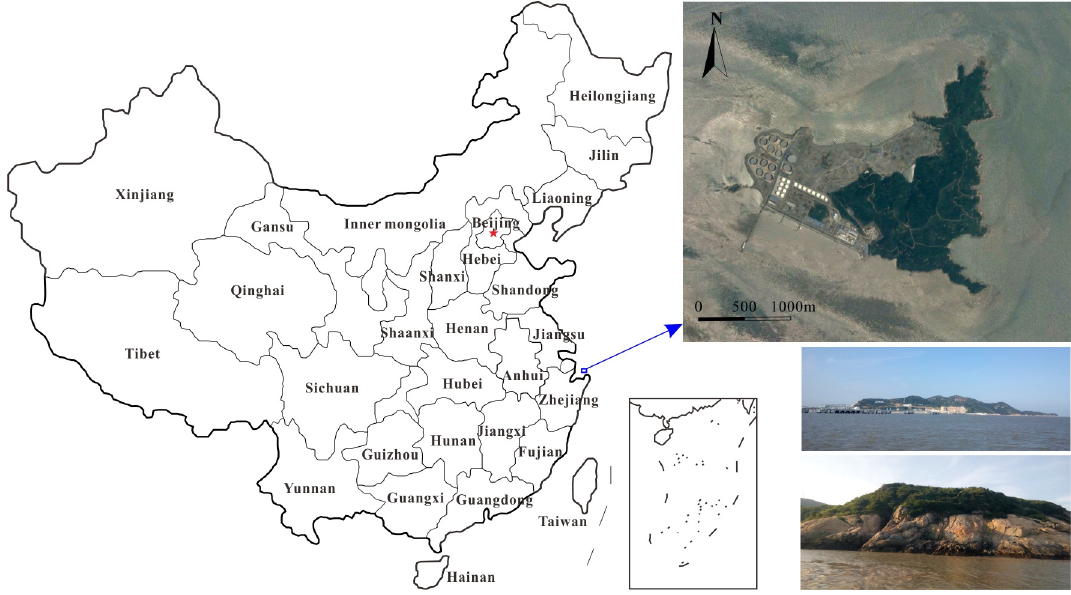
Figure 2. Location map of the research area.